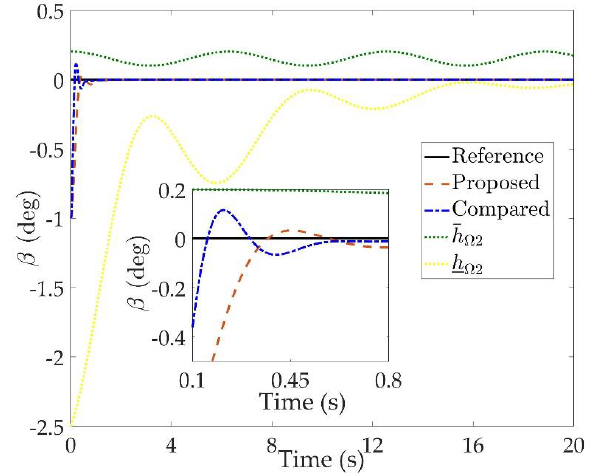
Figure 3. Comparison curves of the sideslip β tracking performance. Sensors 2020 , 20 , 848